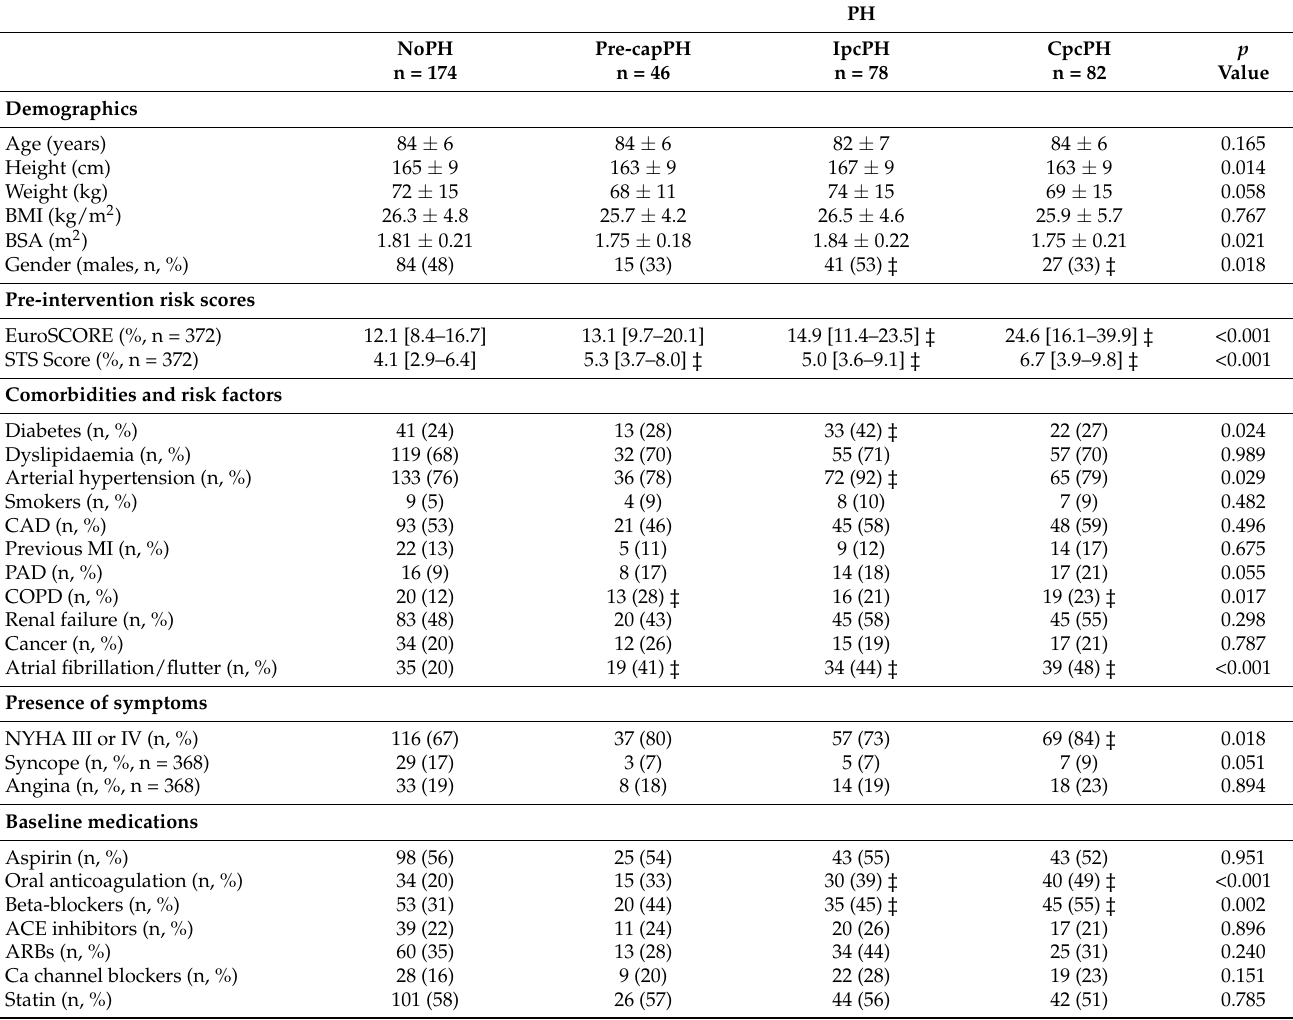
Table 2. Baseline characteristics of the study population according to the PH